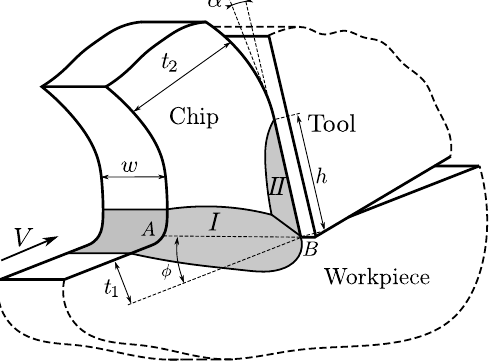
Figure 1. Orthogonal metal cutting